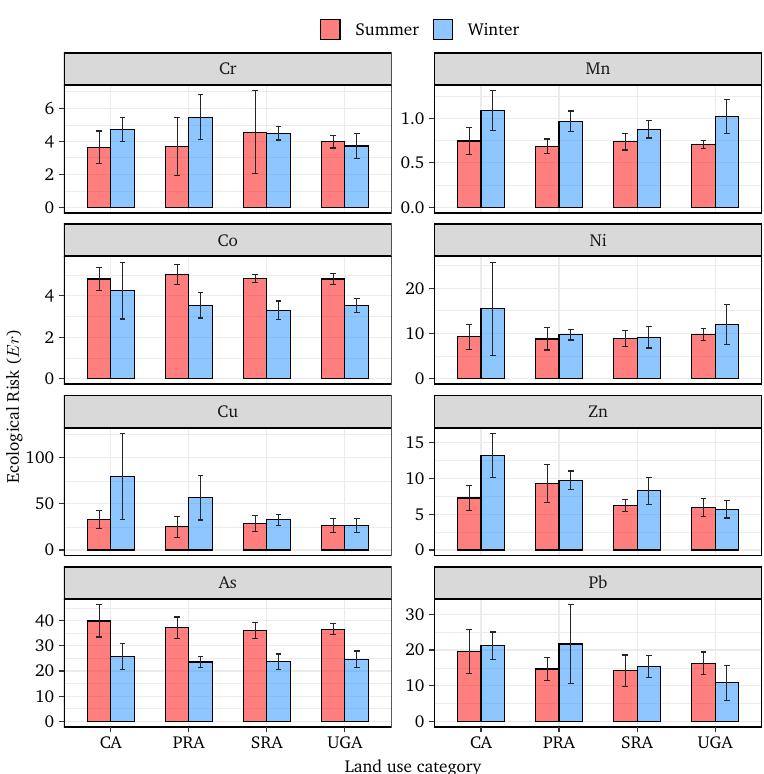
Figure 7. Ecological Risk ( Er ) of heavy metals at different land-use categories in Dhaka city. CA = commercial area, PRA = planned residential area, SRA = spontaneous residential area, and UGA = urban green area. The vertical bars represent standard